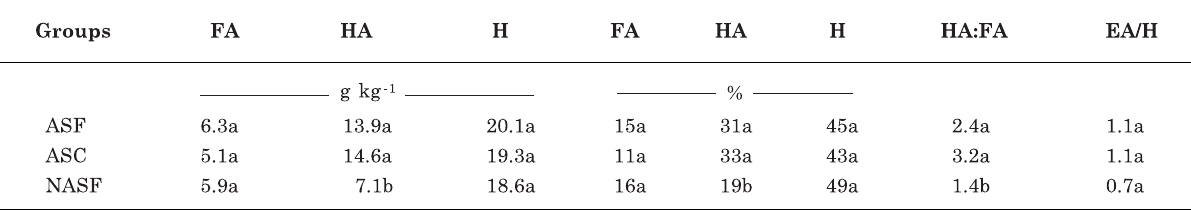
FA: fulvic acid fraction, HA: humic acid fraction, H: humin fraction, EA: the alkali soluble fractions of humic substances (FA + HA = EA). The values indicated by different letters within a column are different at p ≤ 0.05. ASF: anthropogenic soils under forest; ASC: anthropogenic soils under cultivation; NASF: non-anthropogenic soils under